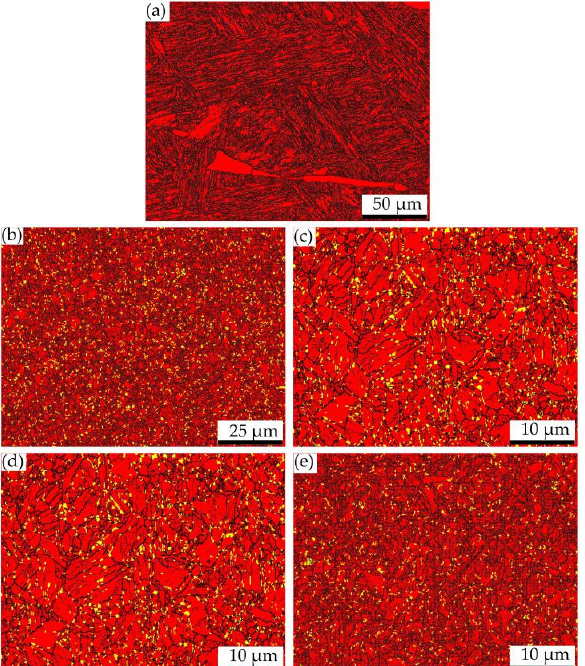
Figure 5. Phase content and grain boundary distribution diagram. ( a ) Original casting; ( b ) once repair welding WM; ( c ) once repair welding HAZ; ( d ) twice repair welding WM; ( e ) twice repair welding HAZ.